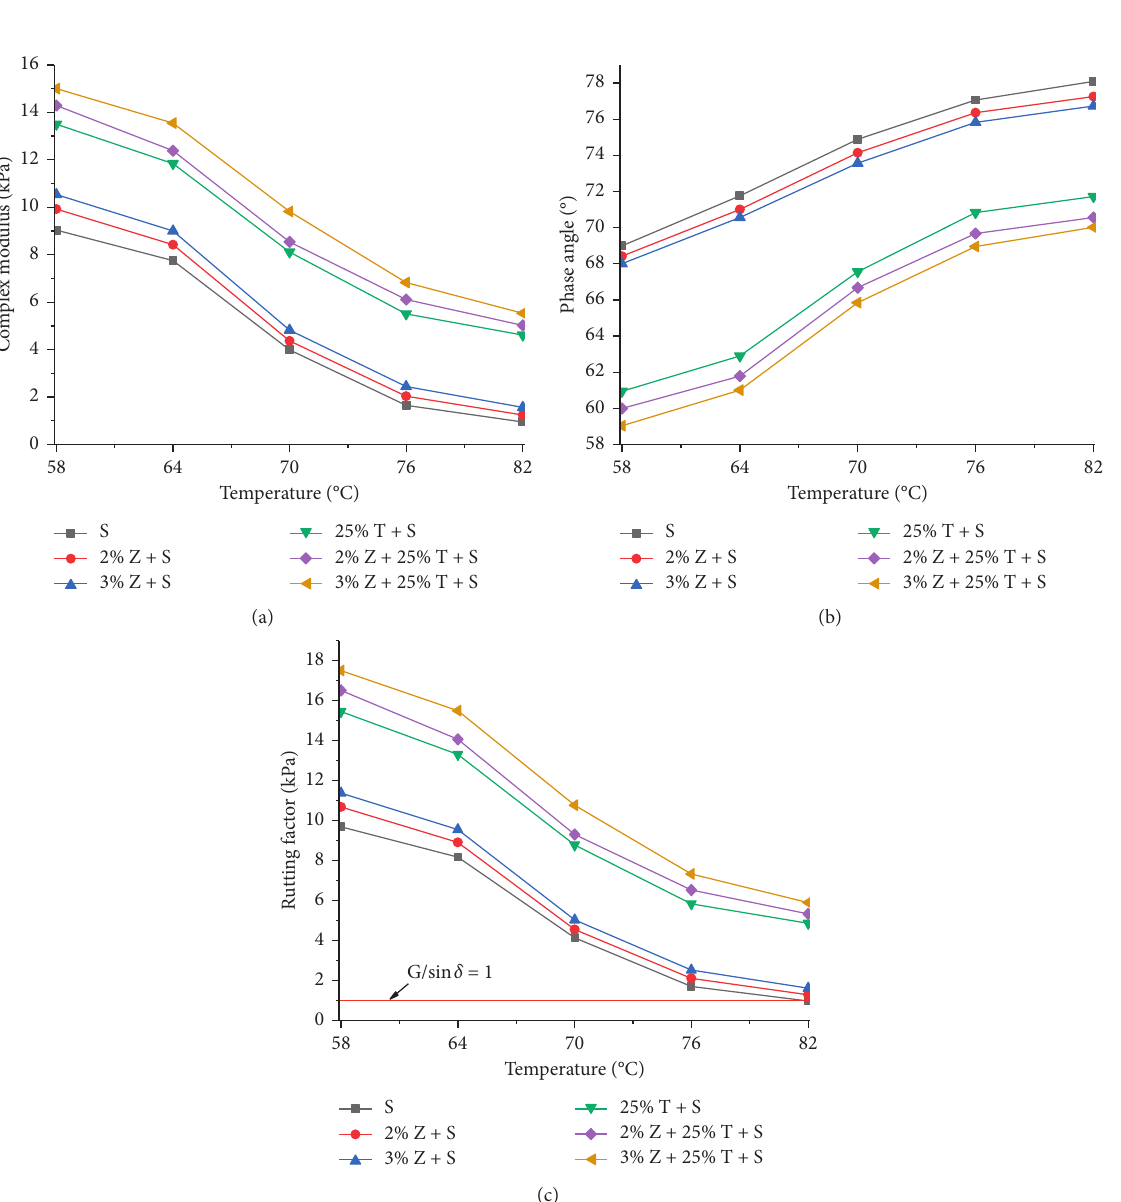
Figure 1: Effect of different content of nano-ZnO (Z) and TLA (T) on rheological properties of SBS asphalt (S). (a) Complex modulus for asphalt. (b) Phase angle for asphalt. (c) Rutting factor for